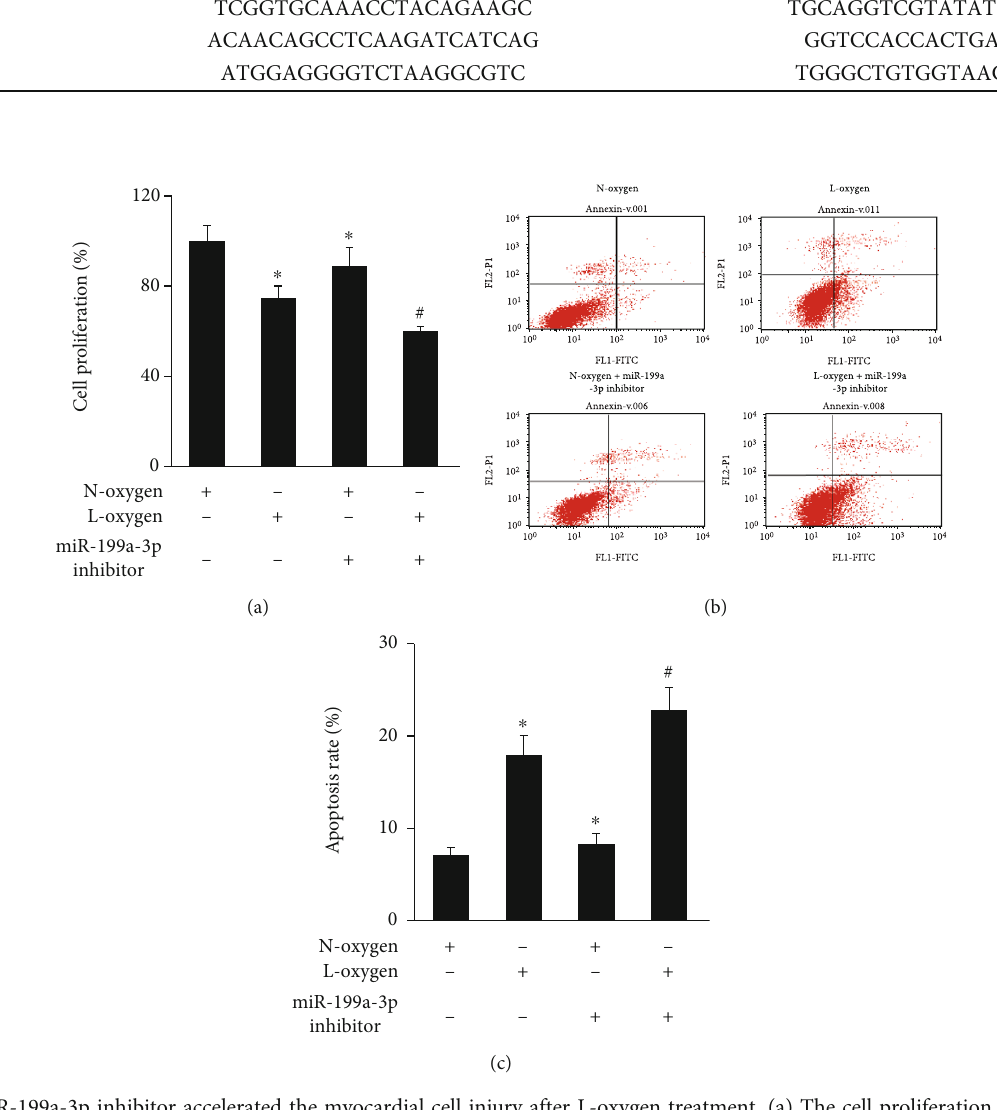
Figure 1: miR-199a-3p inhibitor accelerated the myocardial cell injury after L-oxygen treatment. (a) The cell proliferation was measured after L-oxygen, N-oxygen, or miR-199a-3p inhibitor administrations. (b) The cell apoptosis was measured after L-oxygen, N-oxygen, or miR-199a-3p inhibitor treatment. (c) Cell apoptosis was quanti fi ed. ∗ P < 0 : 05 compared to group N-oxygen. # P < 0 : 05 compared to group